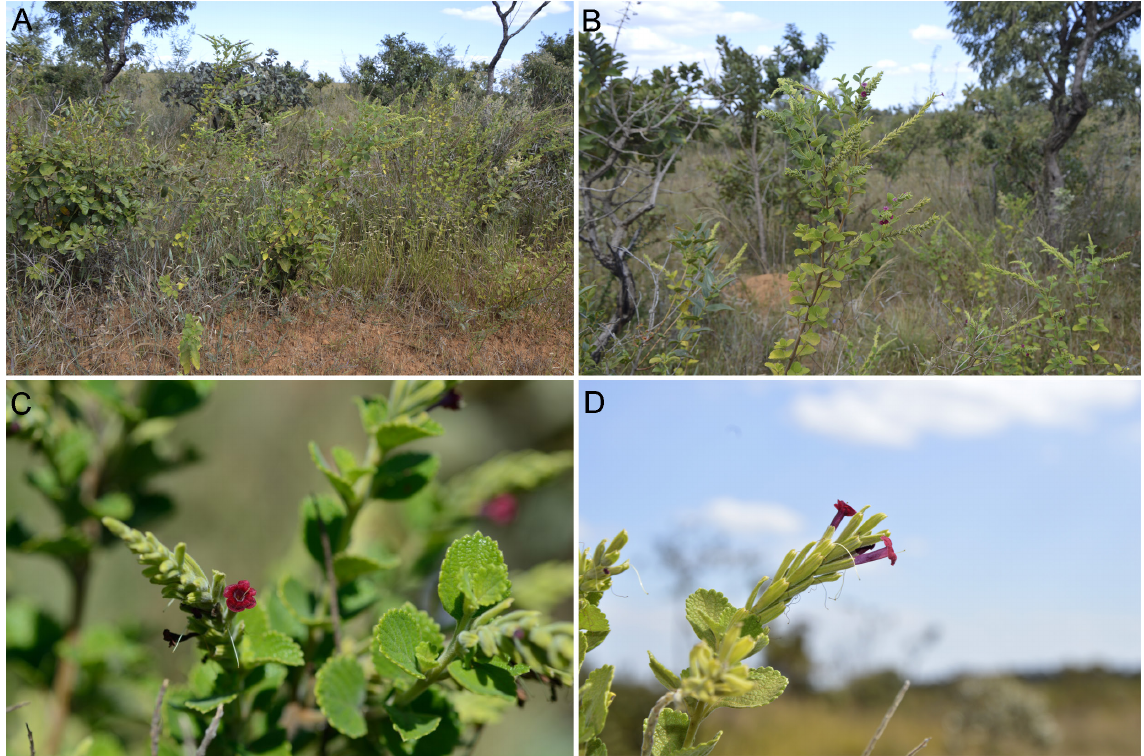
Fig. 9. Stachytarpheta brevibracteata (Moldenke) P.H.Cardoso comb. and stat. nov. A . Habitat. B . Habit. C–D . Individuals showing details of the leaves and inflorescences, highlighting the short pedicels,